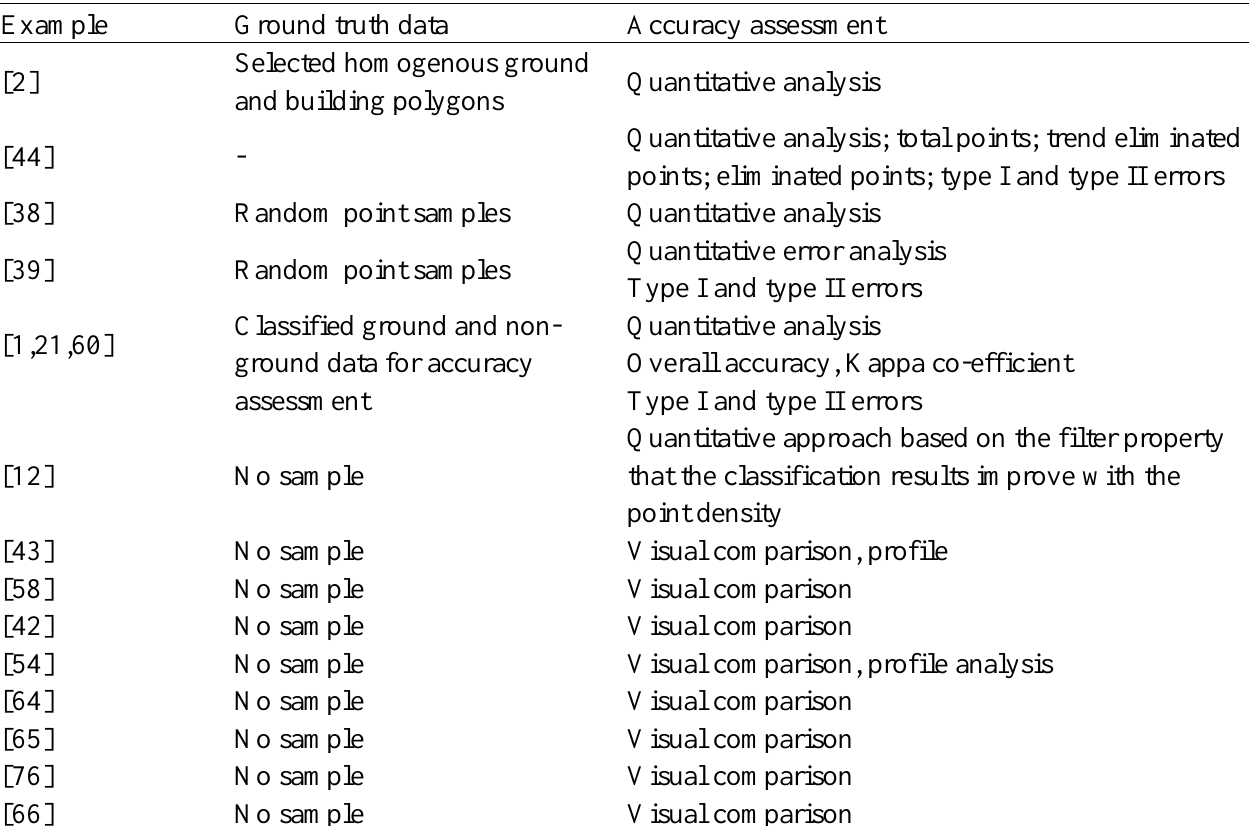
Table 2. Comparative table of accuracy